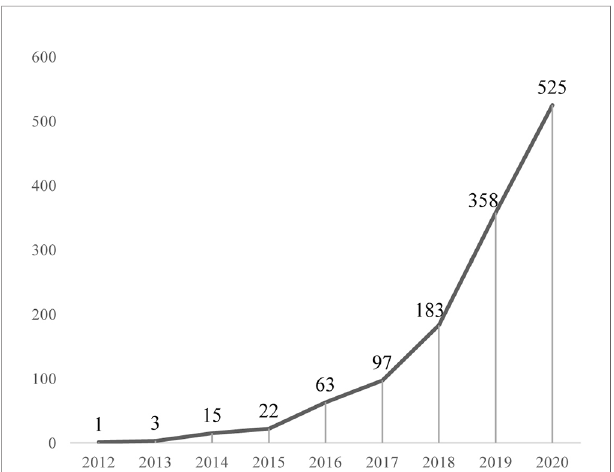
FIGURE 1 | Annual output of ferroptosis